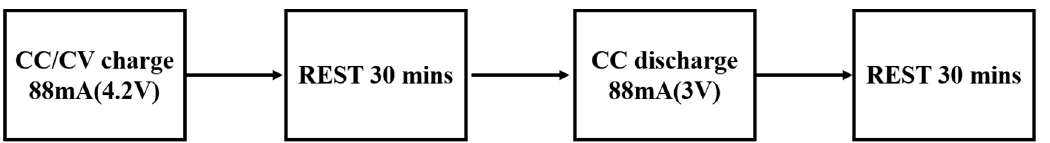
Figure 1. Activation flowchart (LOOP 5 times).